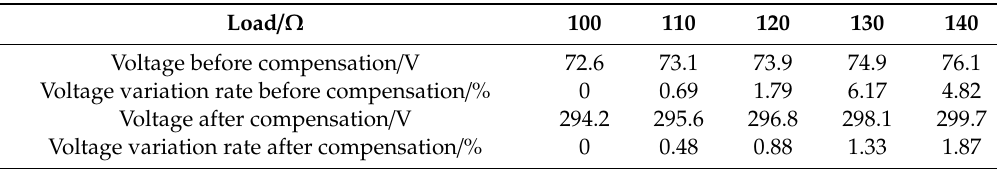
Table 2. The output voltage before and after compensation.